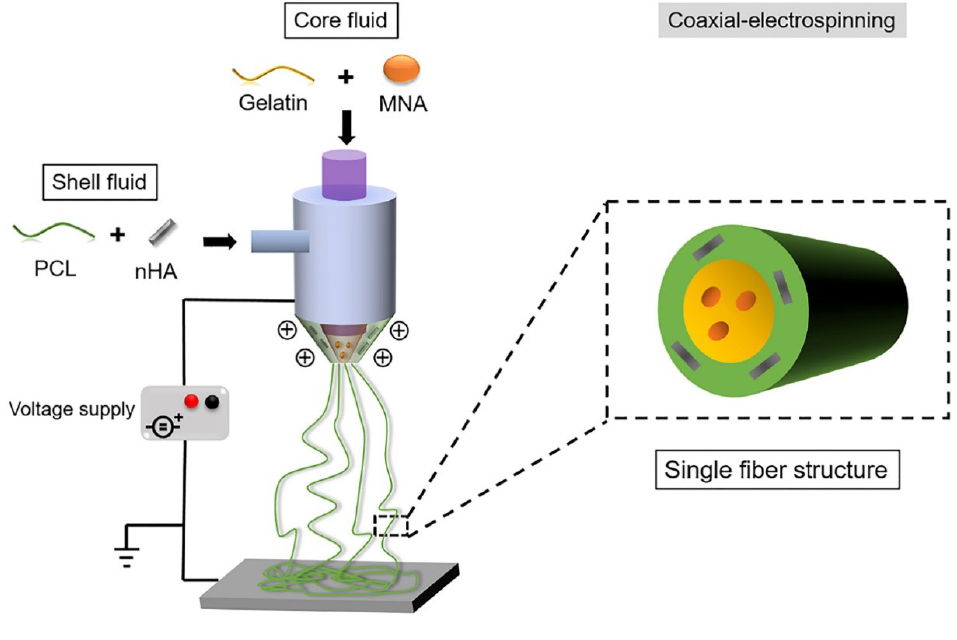
Figure 4. Generating the core-shell structure, reprinted from Ref. [41].